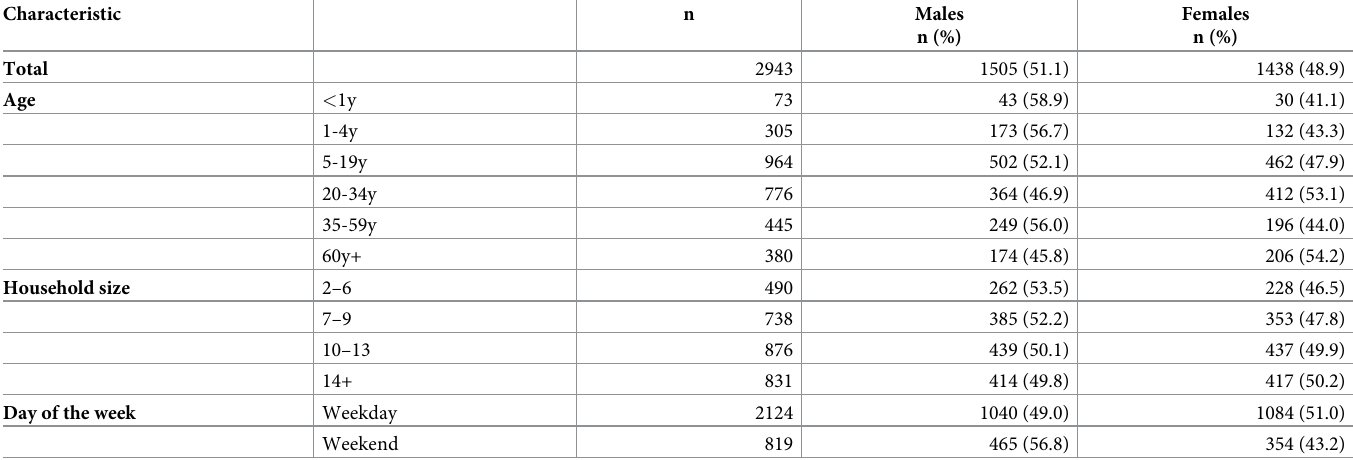
Table 1. Characteristics of respondents stratified by